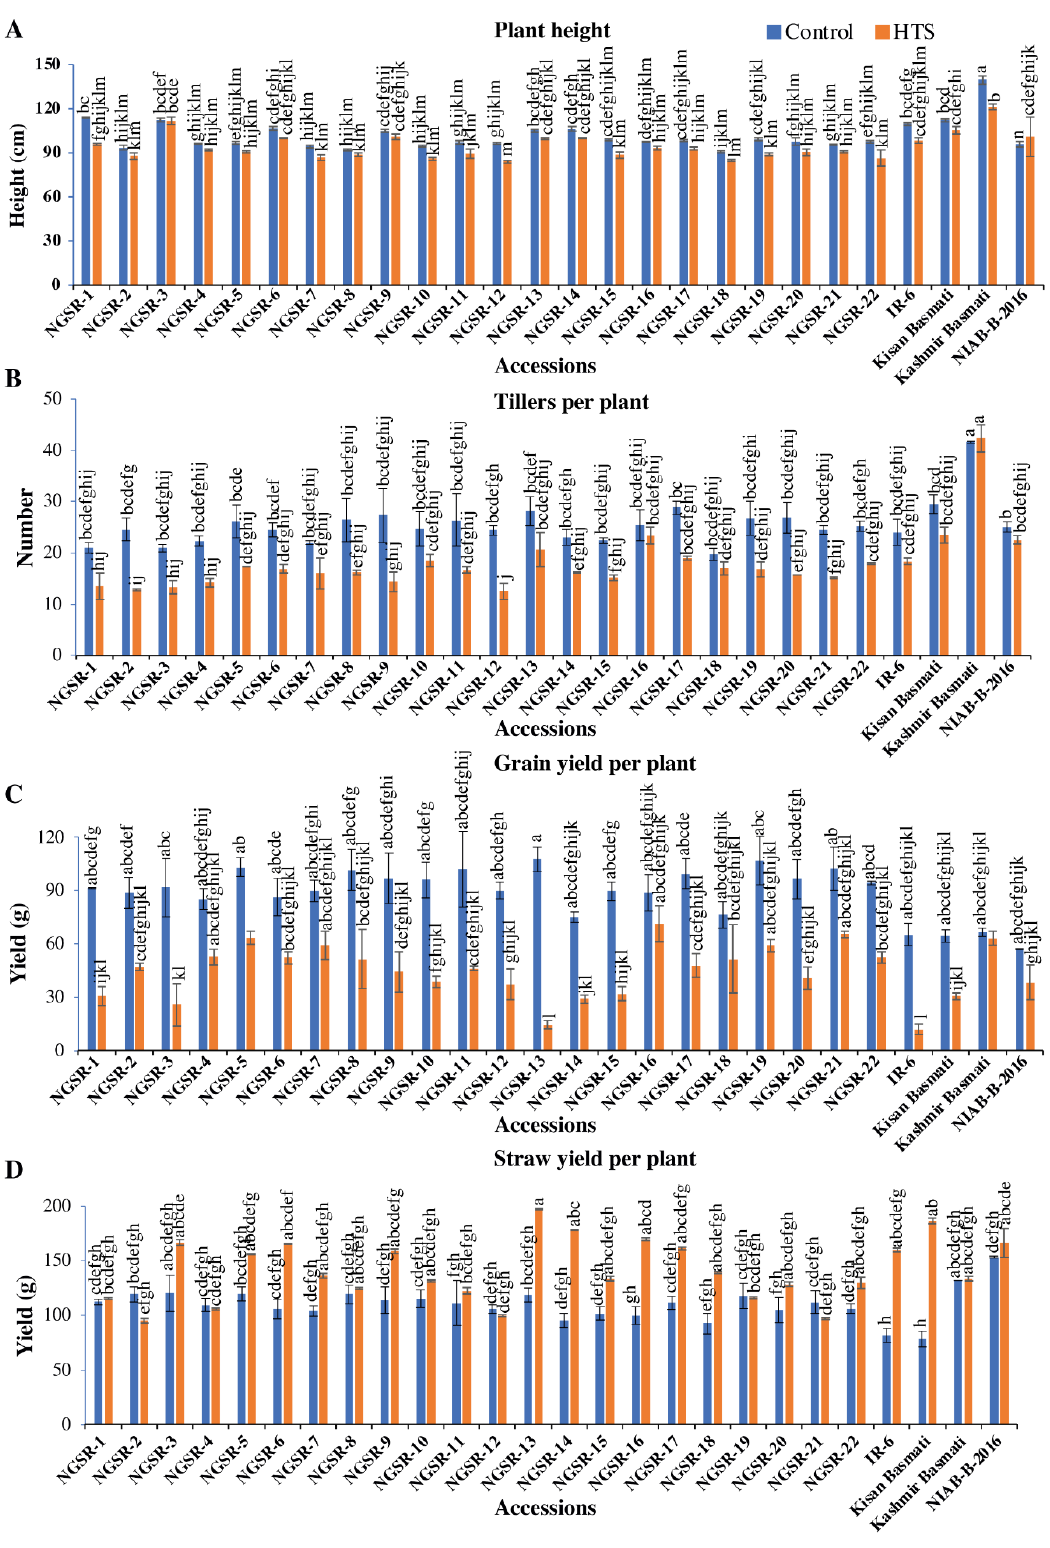
Figure 2. Evaluation of 22 GSR lines and four control variants under control and heat stress. Data for plant height ( A ), tillers per plant ( B ), grain yield per plant ( C ), and straw yield per plant ( D ) were recorded under both conditions. Tuckey’s test was used for statistical differences. Different letters above the column varied significantly at p < 0.05.